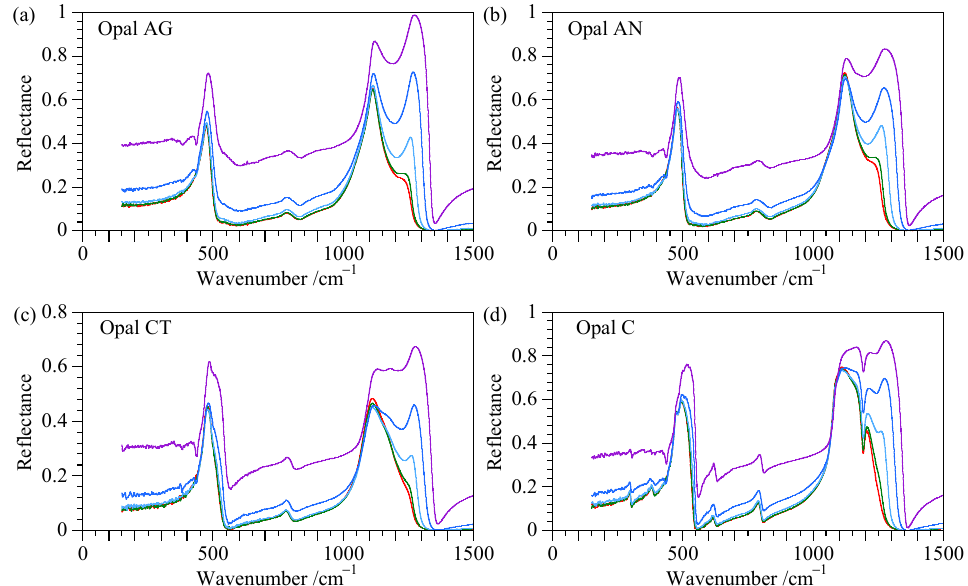
Figure 5. Specular reflectance spectra (unpolarised light) of polished thin segments of ( a ) opal-AG (CP-2 from Coober Pedy, South Australia, Australia), ( b ) opal-AN (MS-1 from Mount Squaretop, Queensland, Australia), ( c ) opal-CT (G9942 from Angaston, South Australia, Australia) and ( d ) opal-C (T1664 from Guanajuanto, Mexico) (red 15°, green 30°, light blue 45°, blue, 60° and violet 75°).